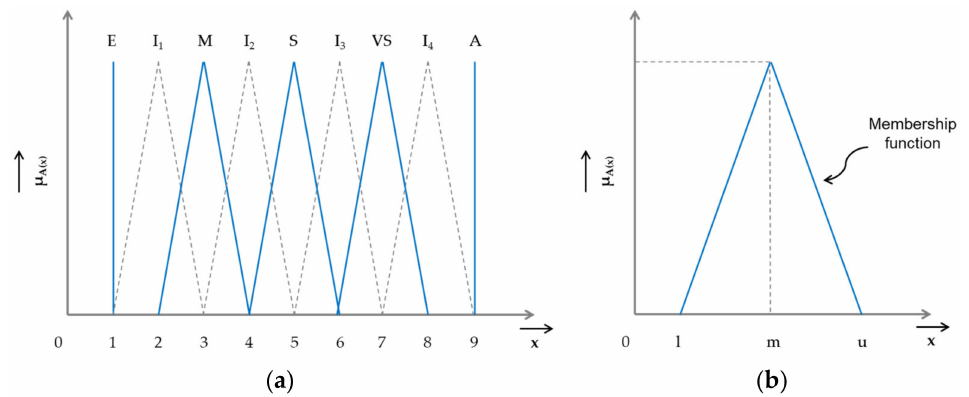
Figure 4. Fuzzy linguistic ( a ) fuzzy scale for FAHP with linguistic variables ( b ) geometric representa- tion of a TFN; (Adapted from: